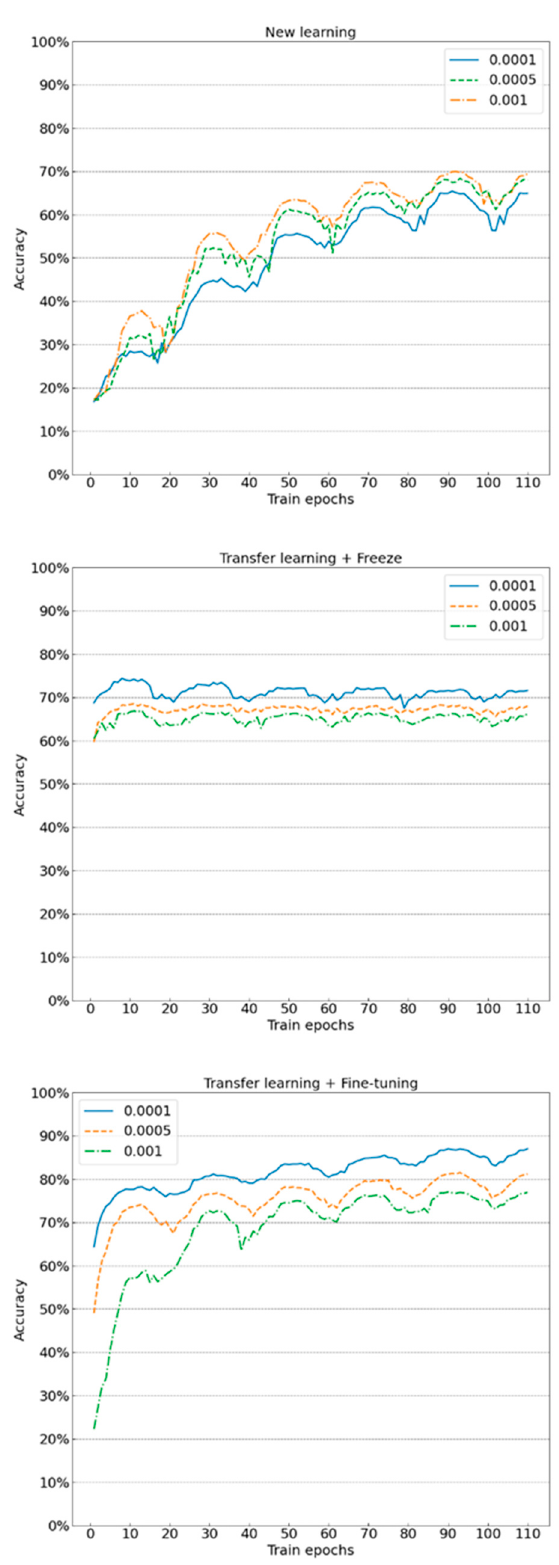
Figure 6. Accuracy of models with different learning rates.